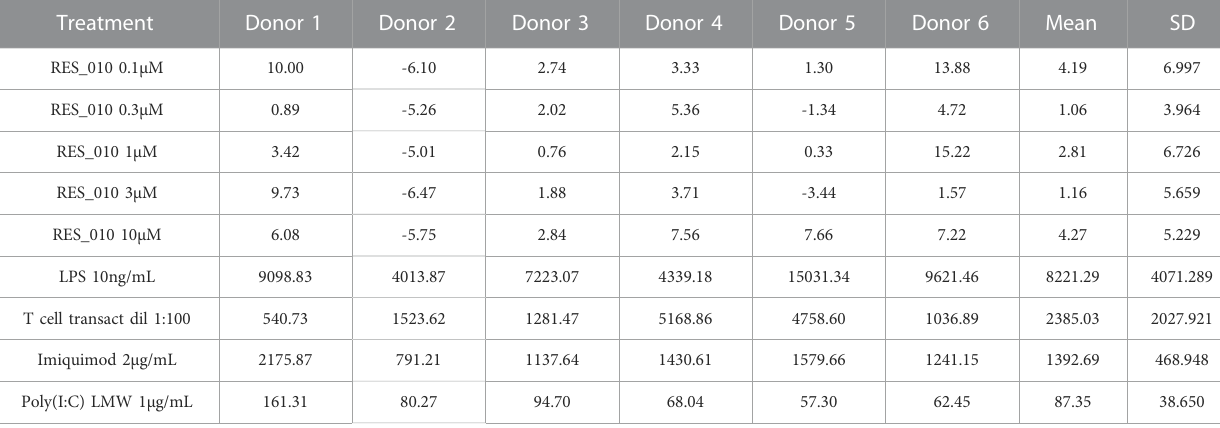
TABLE 7 Concentration Data Vehicle Corrected (pg/mL) for Cytokines: IL-10. Treatment